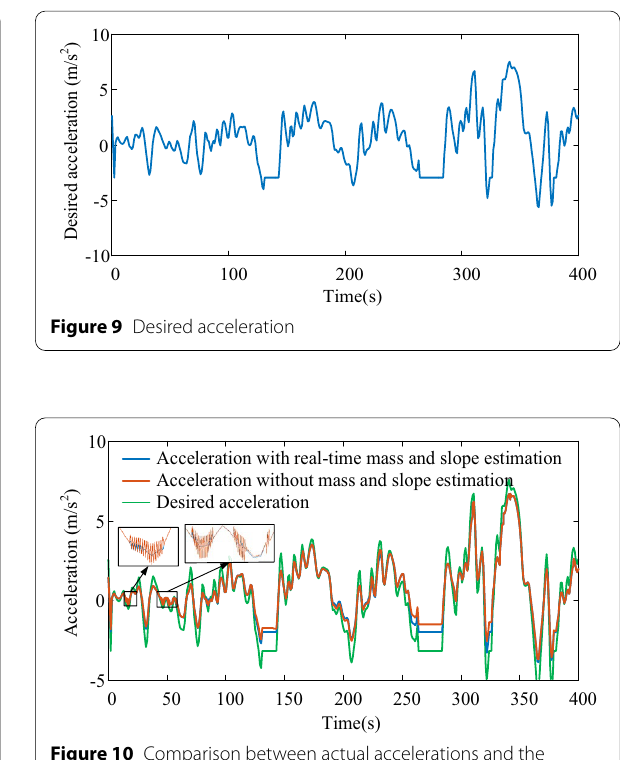
Figure 10 Comparison between actual accelerations and the